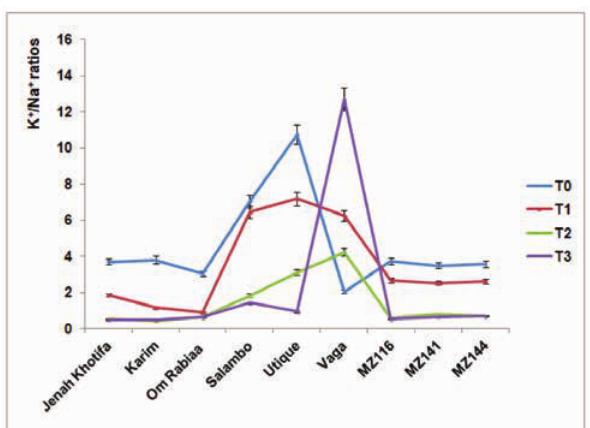
Figure 2: Effect of the four salt treatments (T0=0, T1=50, T2=100 and T3=150 mM NaCl) on the K+/Na+ ratios among the investiga- ted durum wheat (Jenah Khotifa, Karim, Om Rabiaa) and common wheat varieties (Salambo, Utique, Vaga) and wild wheat accessions (MZ116, MZ141,